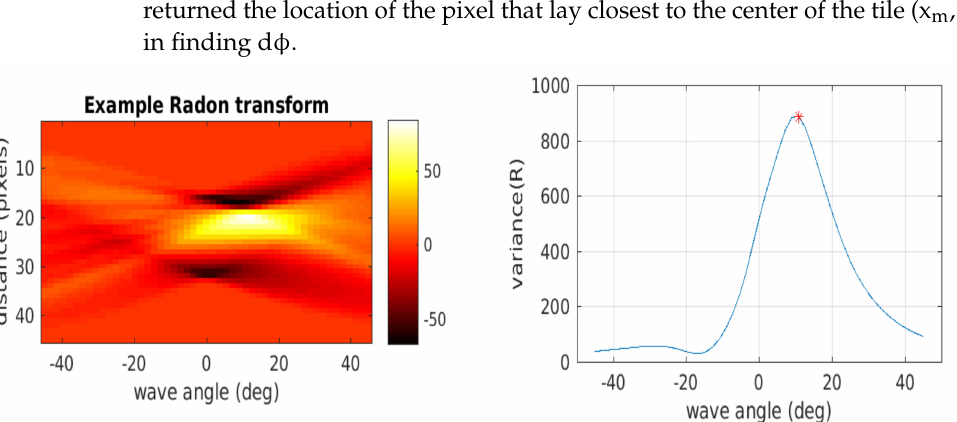
Figure 4. Radon transform results for the example tile and model point shown in Figures 1 and 2. Left panel shows the actual Radon transform versus candidate wave angle ( x -axis) and projected distance ( y -axis). The right panel shows the variance of the Radon transform as a function of wave angle. The angle with maximum variance is chosen as the wave angle seed, in this case 10.8 ◦ .